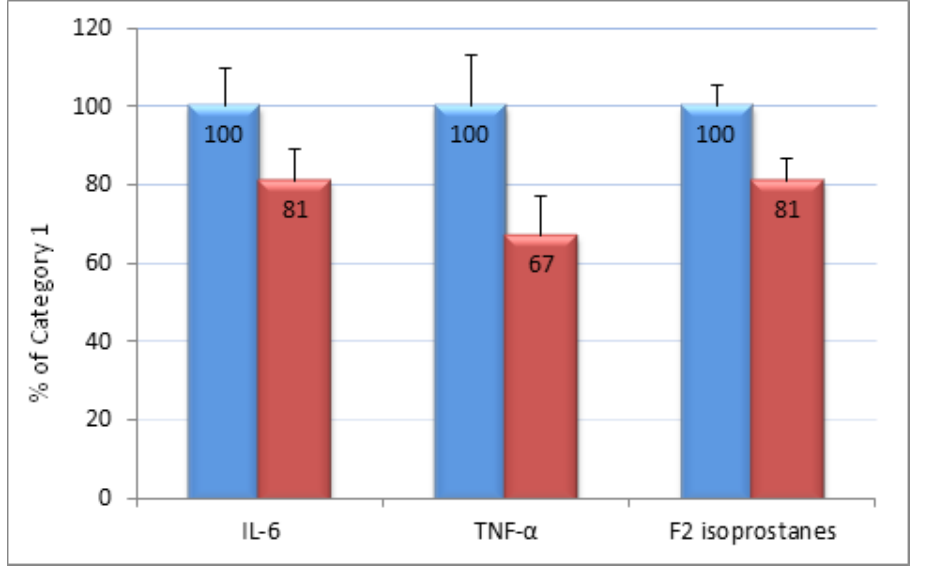
Figure 1. Comparison of category 3 to category 1 of combined fruit and vegetable intake for three biomarkers of inflammation and oxidative stress. For each marker the blue 100% bar represents the value of category 1 while the red bar represents category 3. The error bars are the 95% confidence intervals. The differences between category 1 and 3 for each marker are statistically significant at p ≤